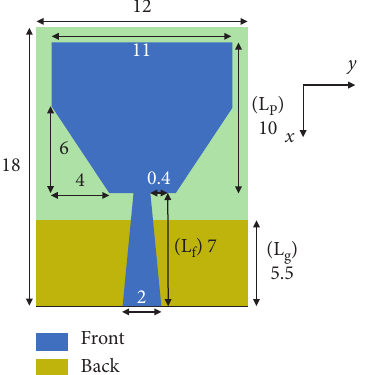
Figure 1: Schematic diagram of UWB antenna structure (mm).